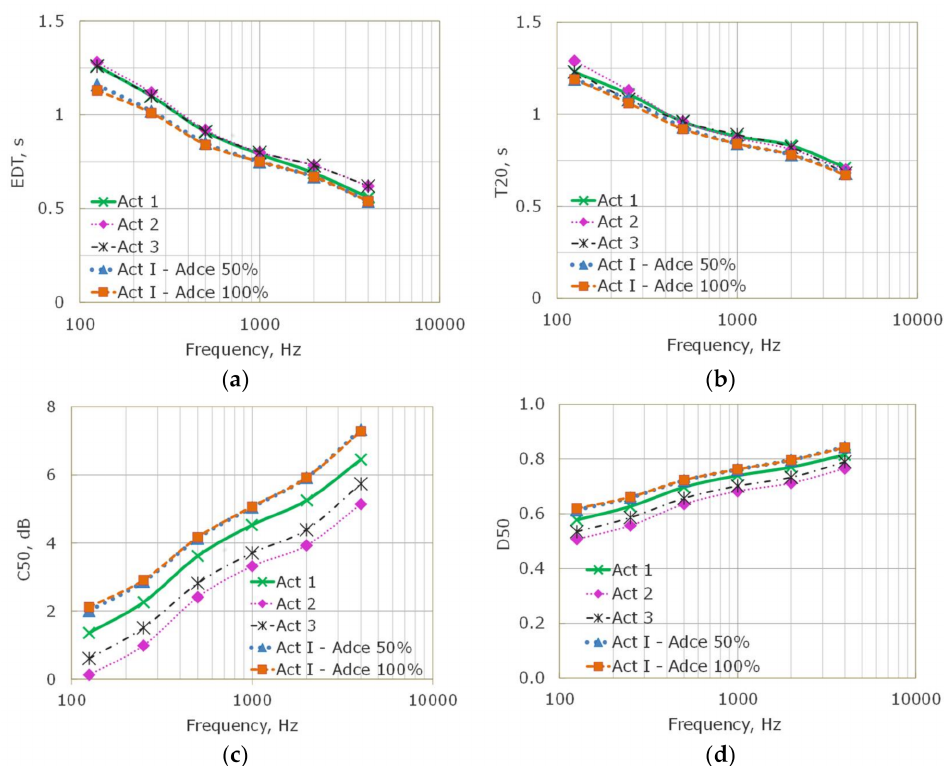
Figure 12. Simulated results of the main acoustic parameters: early decay time ( a ), reverberation time ( b ), clarity index ( c ), and definition ( d